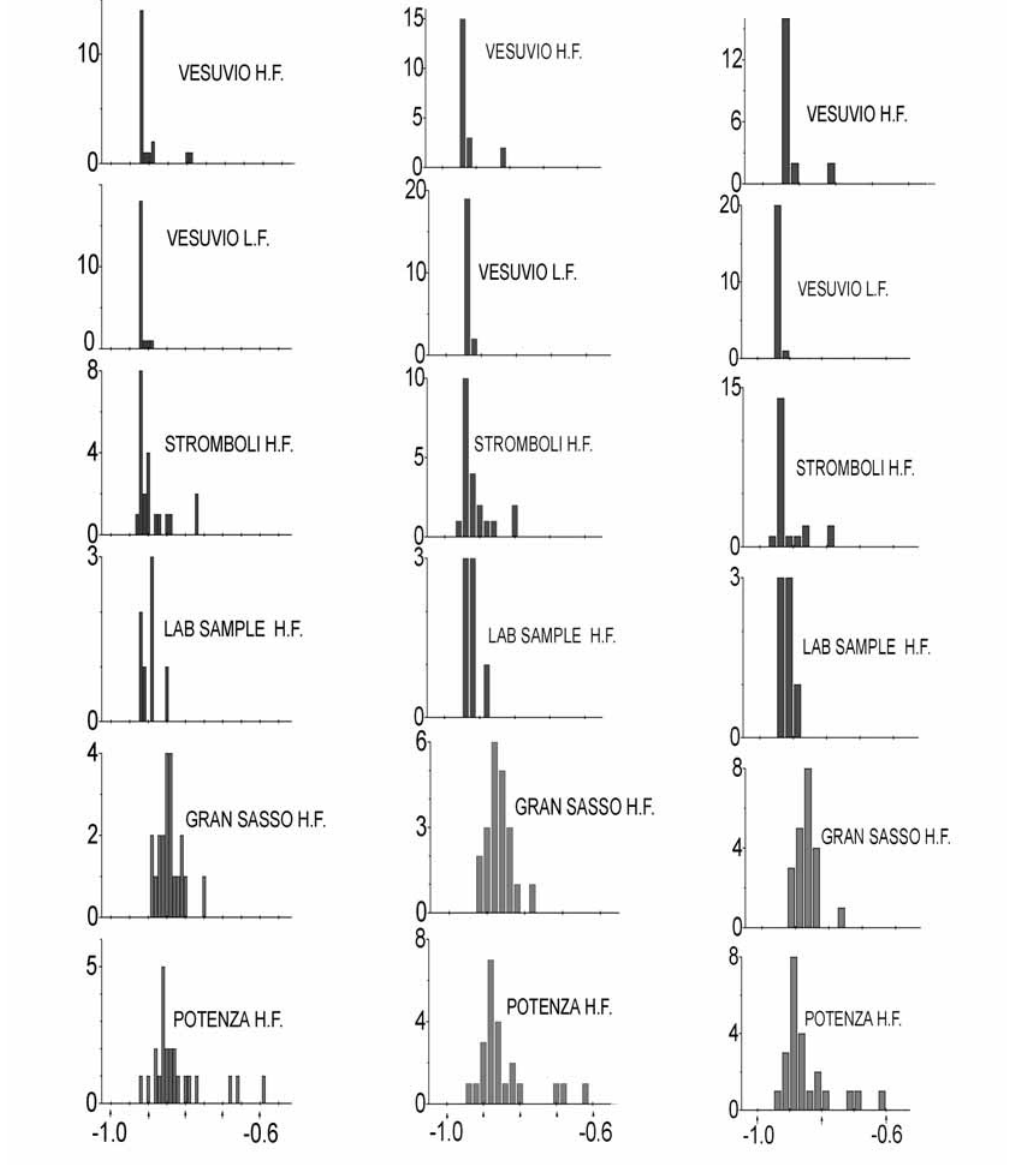
Fig. 3. Statistical distributions of the slopes H computed by the box counting method applied to the 6 case histories listed in table I. The observed distributions seem to partake into two families with D ~ 1. and D ~ 0.9, respectively. Three different histograms for every case are plotted, being defined by the identical data set, though by using different elementary intervals on abscissas. The significance of distinguishing such distributions is tested by means of standard algorithms as per table II. The lowest two lines of histograms are shown with a lighter shading in order to emphasize that their peaks occurr at D ~ 0.9, unlike others that are peaked at D ~